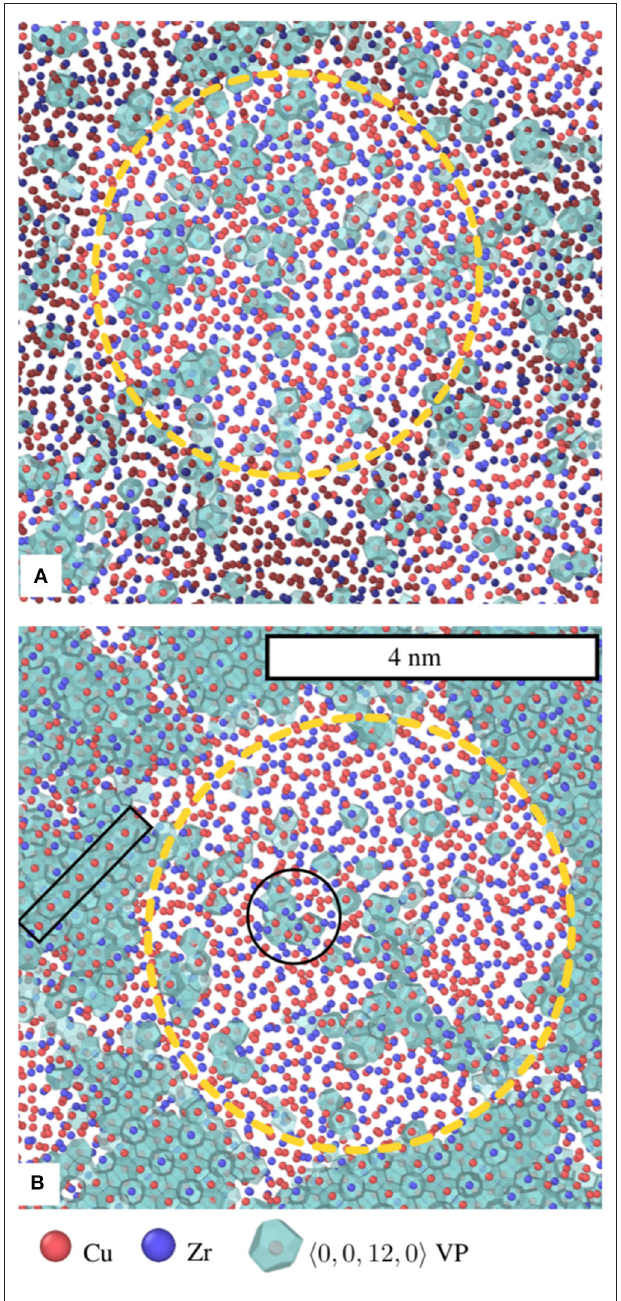
FIGURE 1 | Snapshots of a slice through the (A) conventional NG and (B) nanoglass-crystal composite, showing two amorphous grains embedded in amorphous interphase and crystalline Cu 2 Zr Laves phase, respectively. Copper atoms are depicted in red and zirconium atoms are depicted in blue. The outlines of the grains are indicated with yellow dashed circles. In addition to the atomic configuration, the h 0,0,12,0 i Voronoi polyhedra present in this structure are shown in light blue. This allows for a distinction to be made between atoms in a glassy grain, and the crystalline interphase, where the Cu-centered h 0,0,12,0 i polyhedra must form regular chains of face-sharing VP (marked with a black box). Within the glassy grain, the typical clustering into irregular shapes can be observed (marked with a black